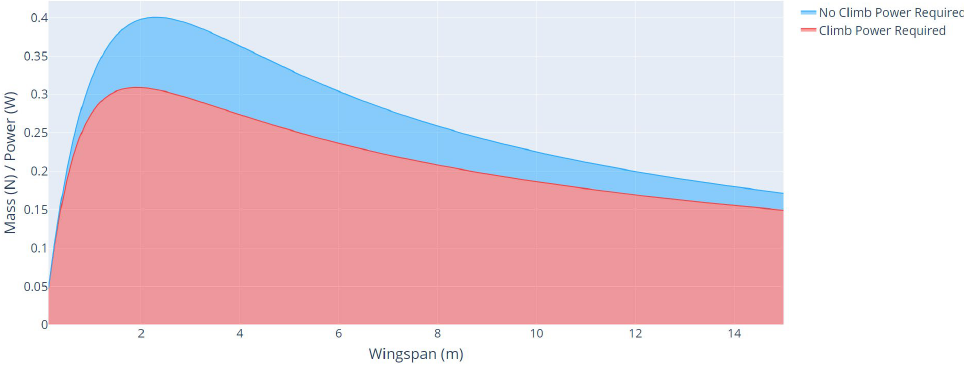
Figure 13. Mass/power ratio as a function of wingspan for aircraft with different mission profiles. Table 6. The main parameters for aircrafts with different mission profiles.